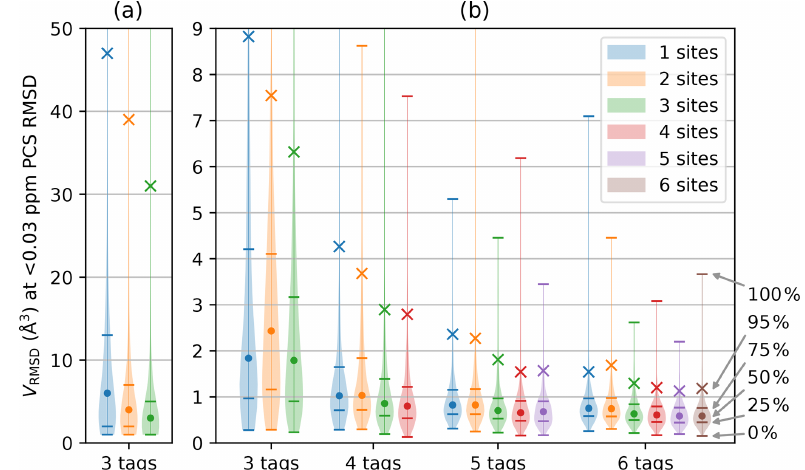
Figure 2. Distribution of V RMSD for (cid:49)χ tensors with 10000 randomly sampled orientations and various tagging site geometries and mul- tiplicities. The distance of the nuclear spin from the paramagnetic centre was 20Å, and δ thresh. was set to 0.03ppm. The widths of the RMSD lines in the horizontal dimension trace the histogram distributions of V RMSD . Percentiles indicated on the right identify the median of the distributions (labelled by a circle), the 95th percentile (marked by a cross) and the quartiles (identified by horizontal lines). (a) Calcula- tions performed for a grid volume of 10 6 Å 3 , with a point density of 1point per Ångström, resulting in 10 6 grid points and (cid:49)V = 1Å 3 . (b) Calculations performed for a grid volume of 1000Å 3 with a point density of 5points per Ångström, resulting in 125000 grid points and (cid:49)V = 0 . 008Å 3 . The V RMSD values in panel (a) are increased due to the coarser point density